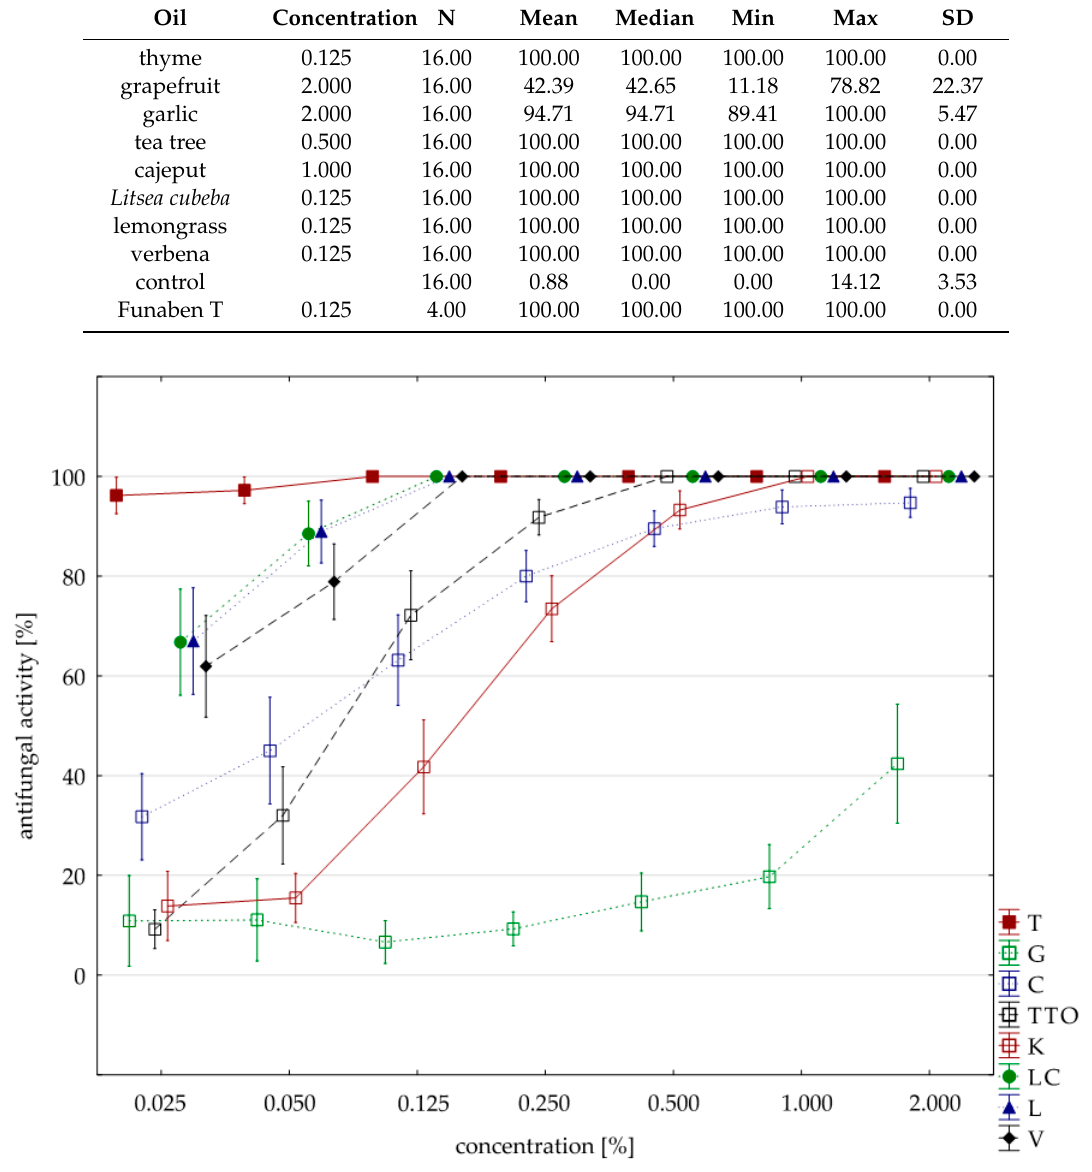
Figure 6. Plot of antifungal activity vs concentration for four species from genus Fusarium (combined analysis) .